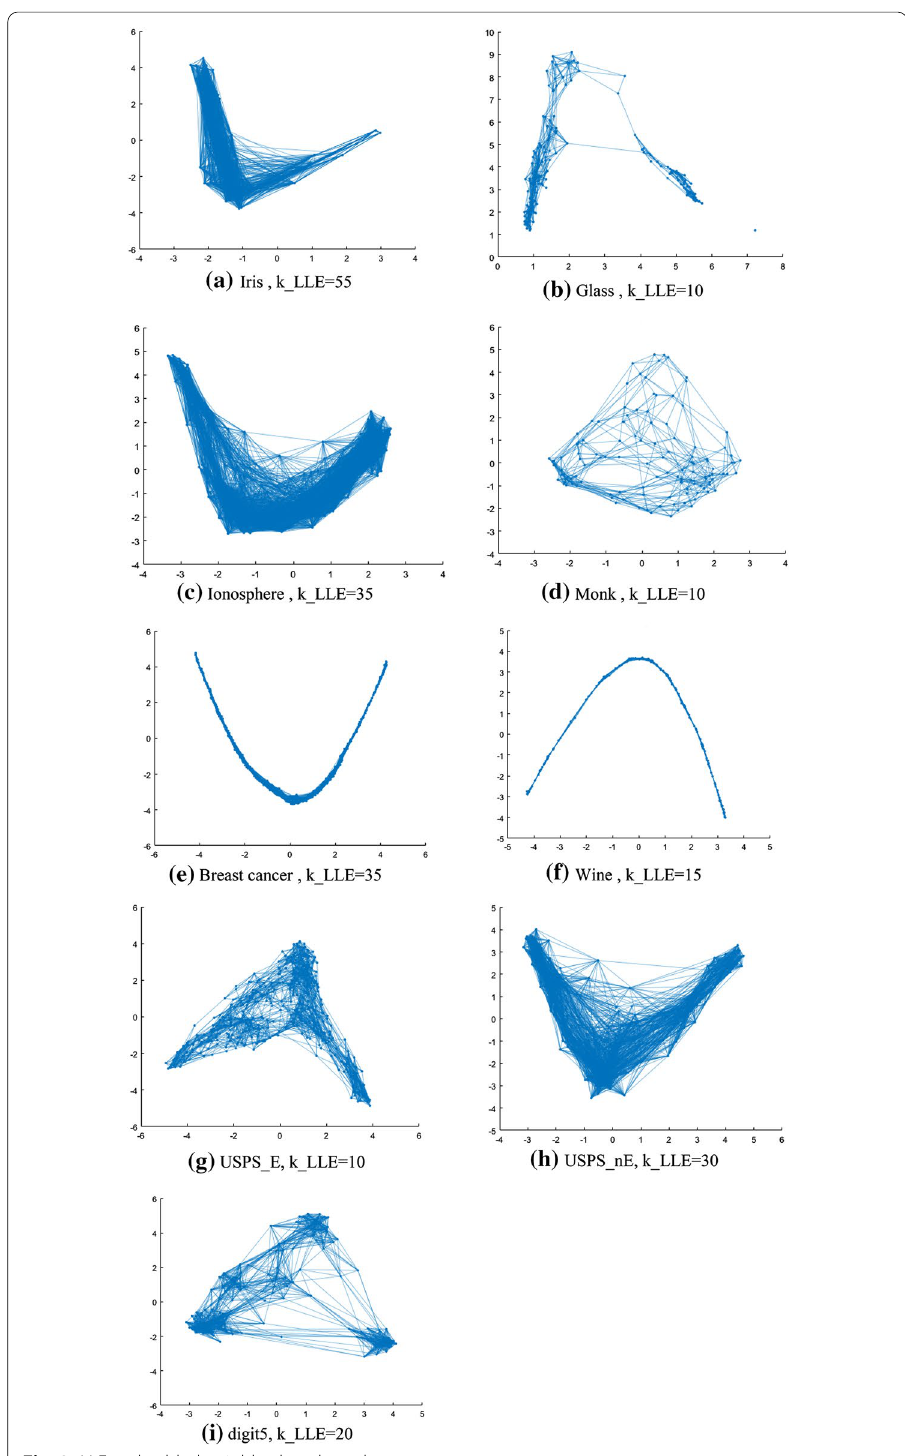
Fig. 3 LLE embedded neighborhood